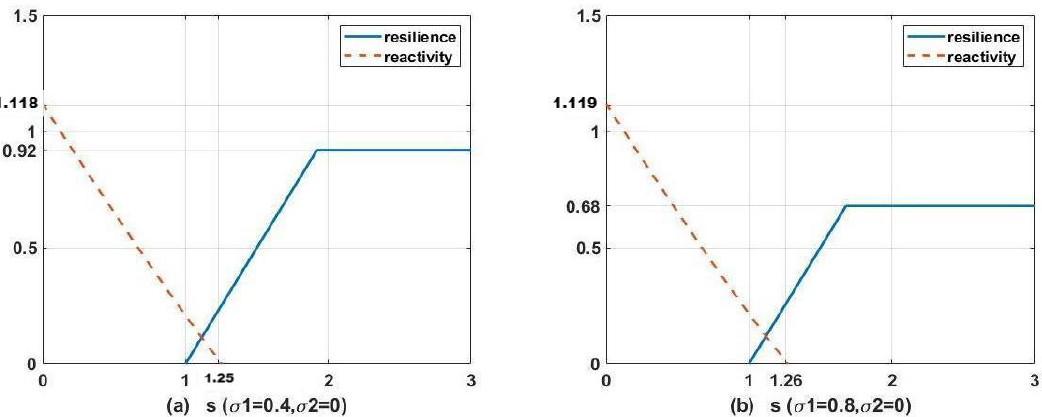
Figure 2. Resilience and reactivity of the system (7) when the prey is disturbed (in the mean square sense).